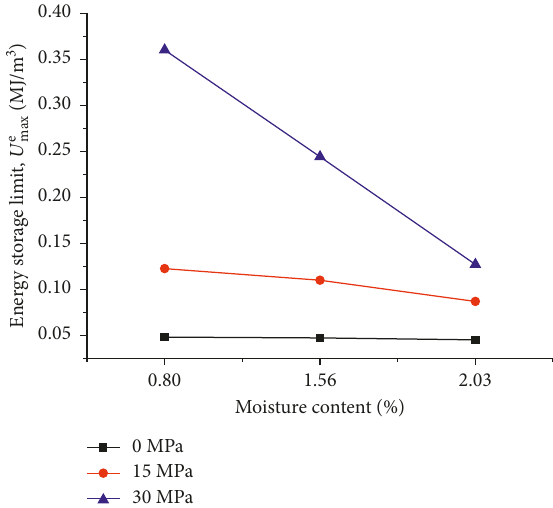
Figure 8: Relationship between energy storage limit and moisture